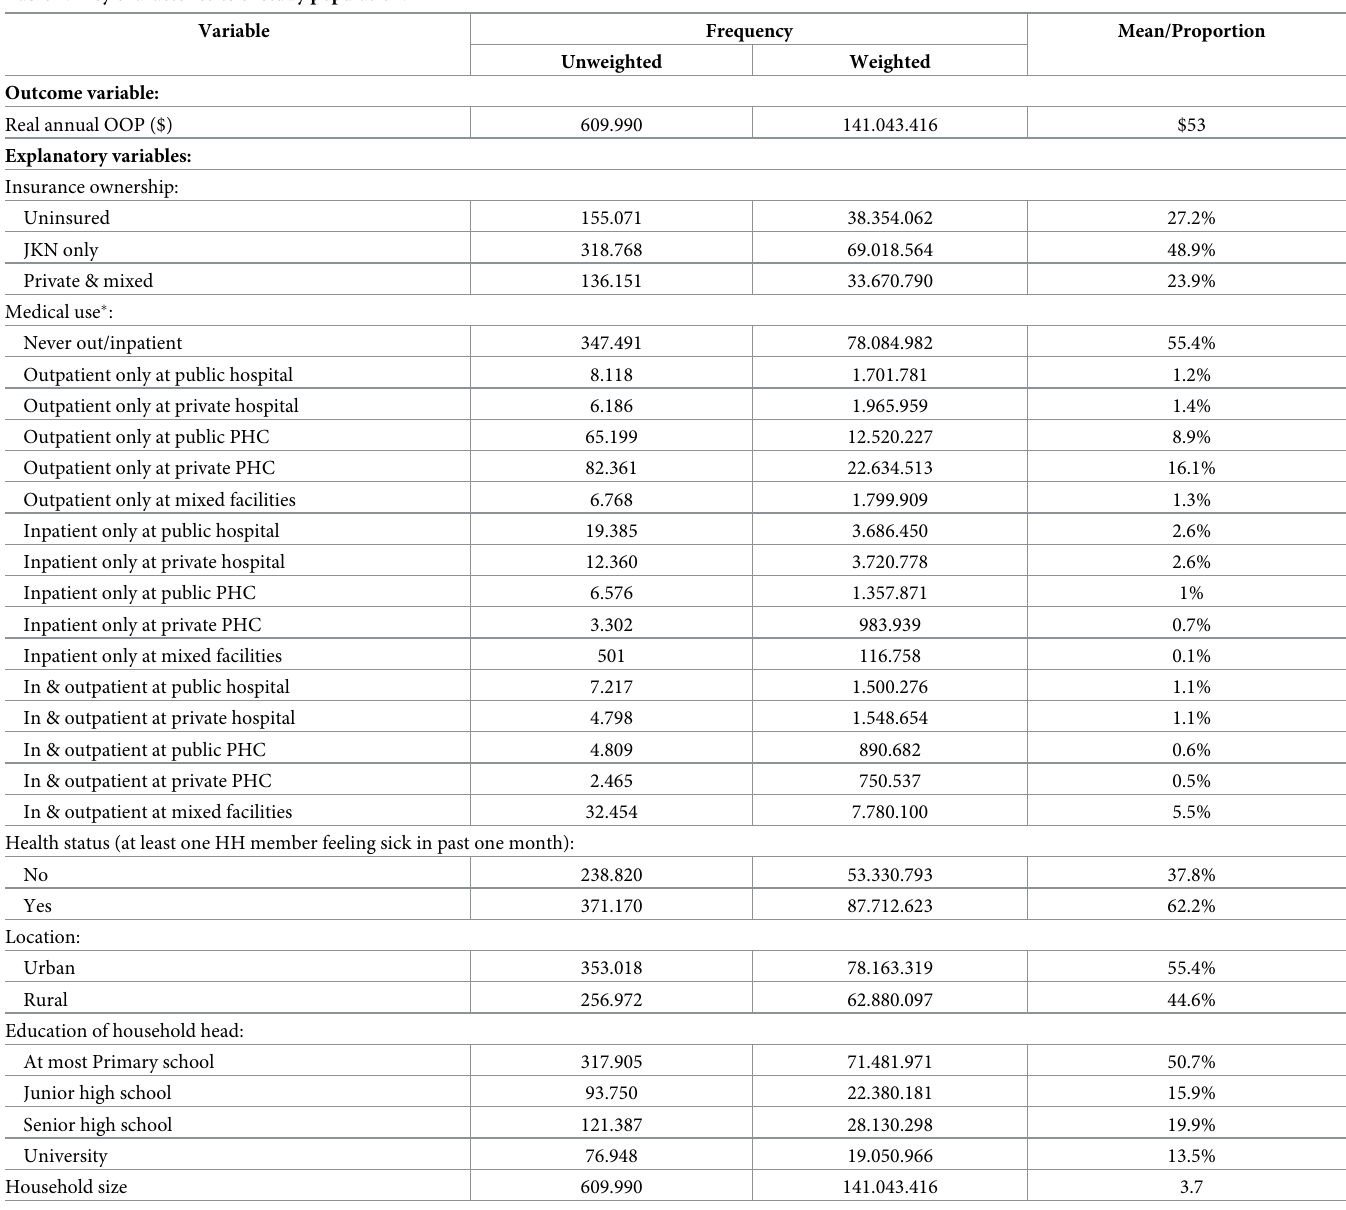
Table 1. Key characteristics of study